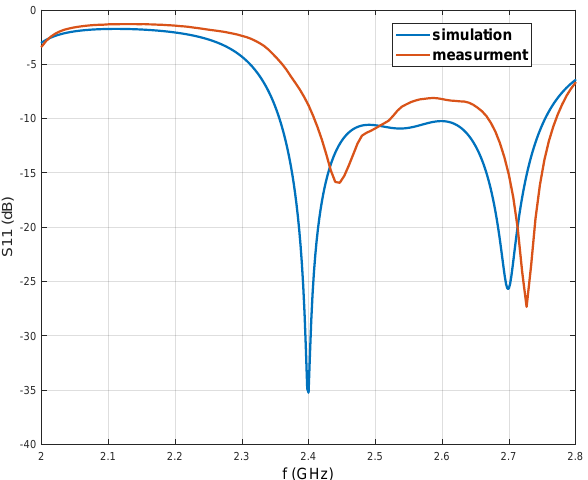
Figure 9. Simulated and measured reflection coefficient ( | S 11 | ) of the 2 × 4